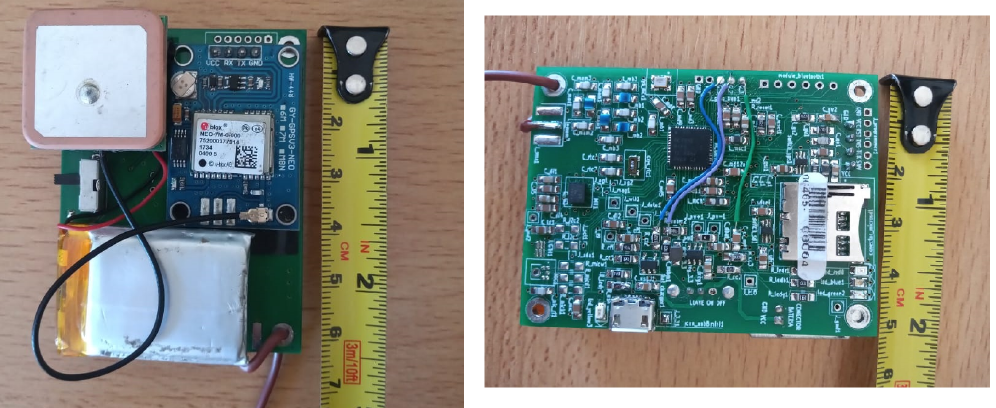
Figure 2. Both sides of the monitoring device (MD) with the corresponding components described in this section. The PCB board dimensions are 48.7 mm × 63.7 mm with 1.6 mm thickness. A ruler with a cm scale is included on the